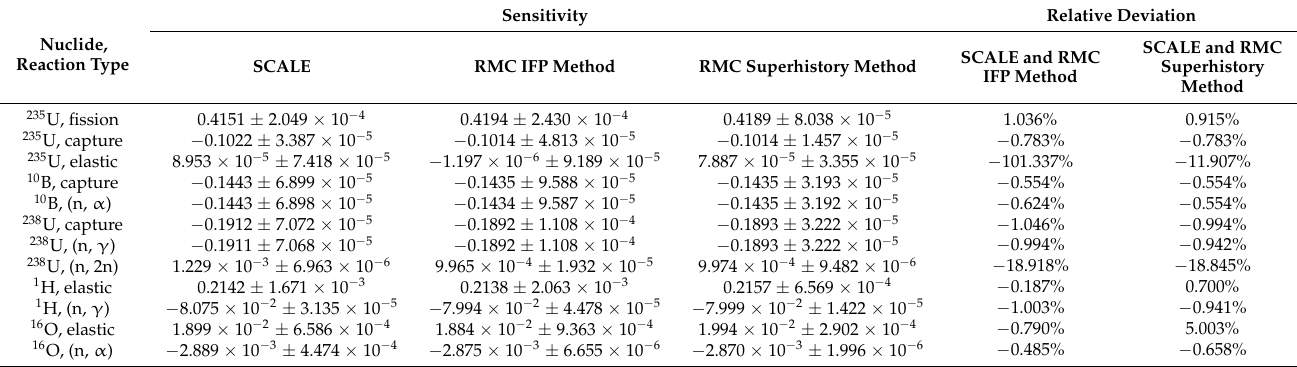
Table 4. SCALE and RMC code k eff sensitivity to nuclear data.